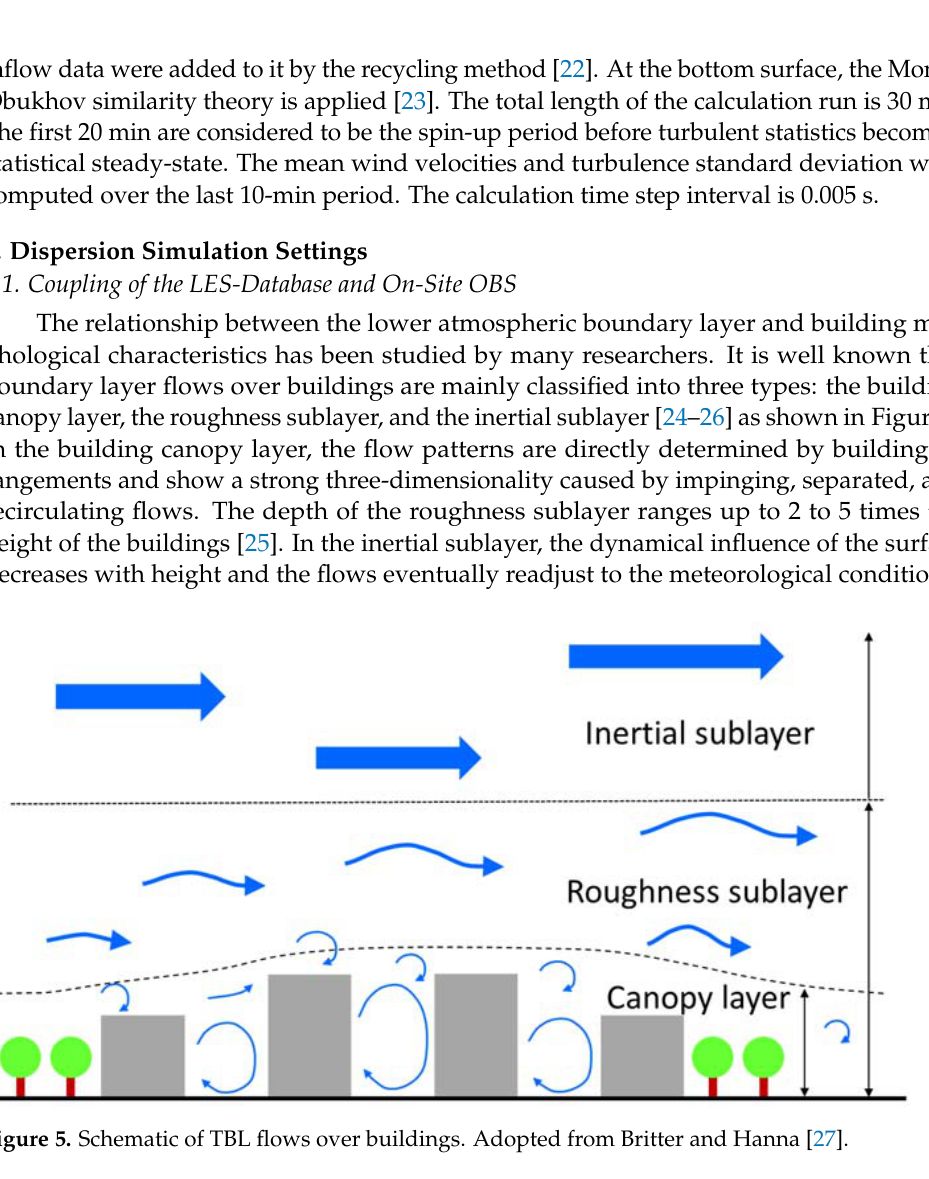
Figure 4. Computational domain for creating the LES-database of mean and turbulent winds over the target site.